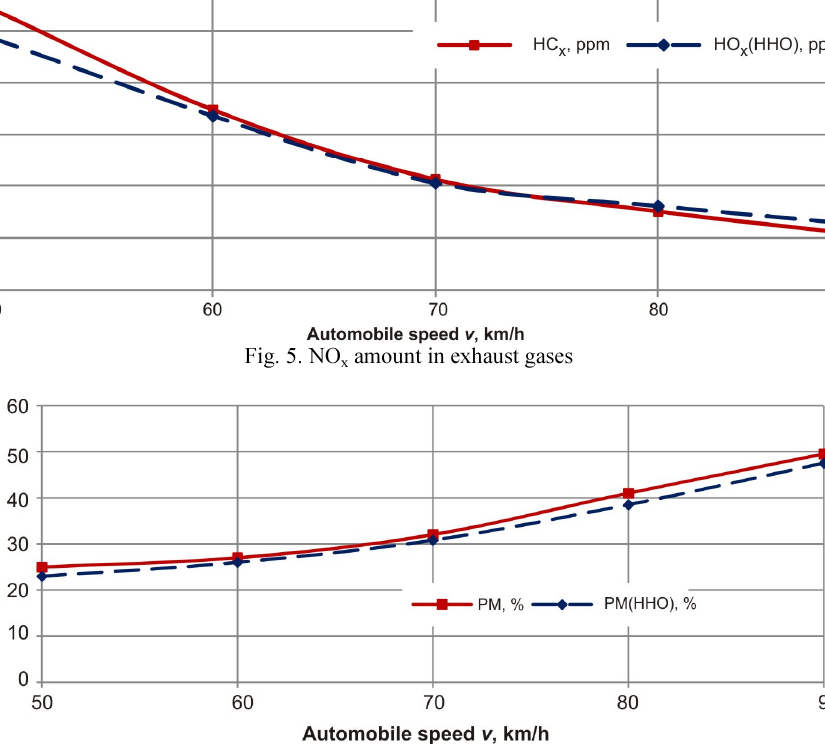
Fig. 6. Amount of particulate mater in exhaust gases